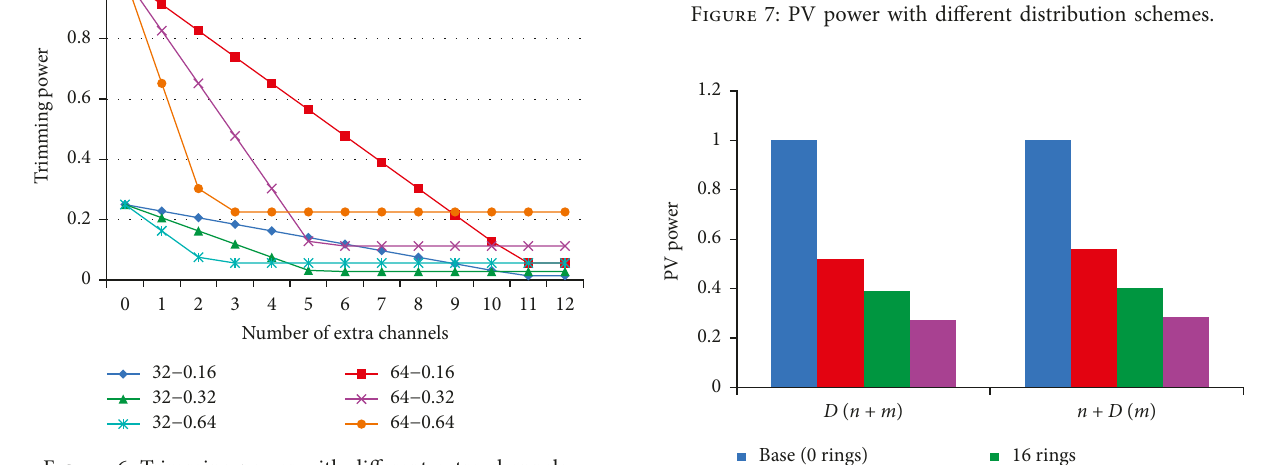
Figure 6: Trimming power with different extra channels.